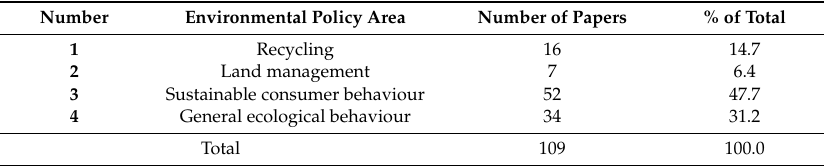
Table 3. Summary of papers based on di ff erent environmental policy